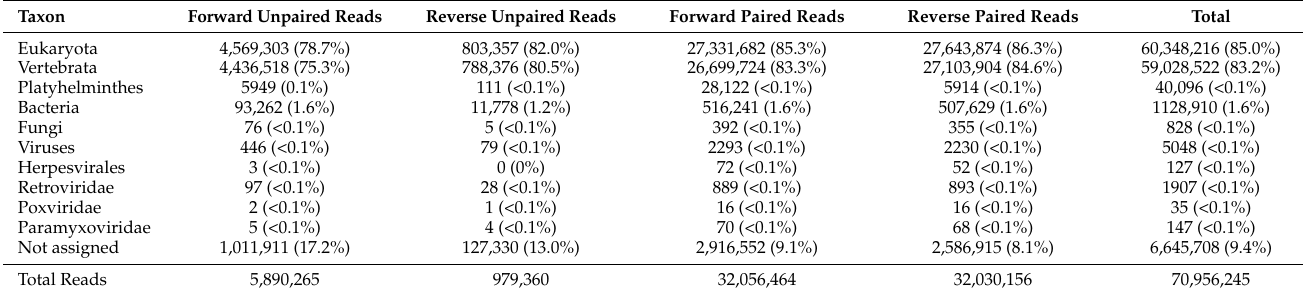
Table 2. Next generation sequencing reads for the Pteropus vampyrus bat from Flores (Site K) with Tioman virus sequences. The predominant taxa in the fastq file are presented with the percentage of total reads.